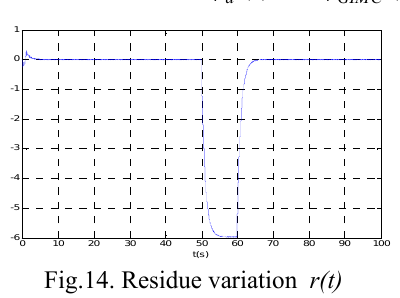
Fig.14. Residue variation r(t)